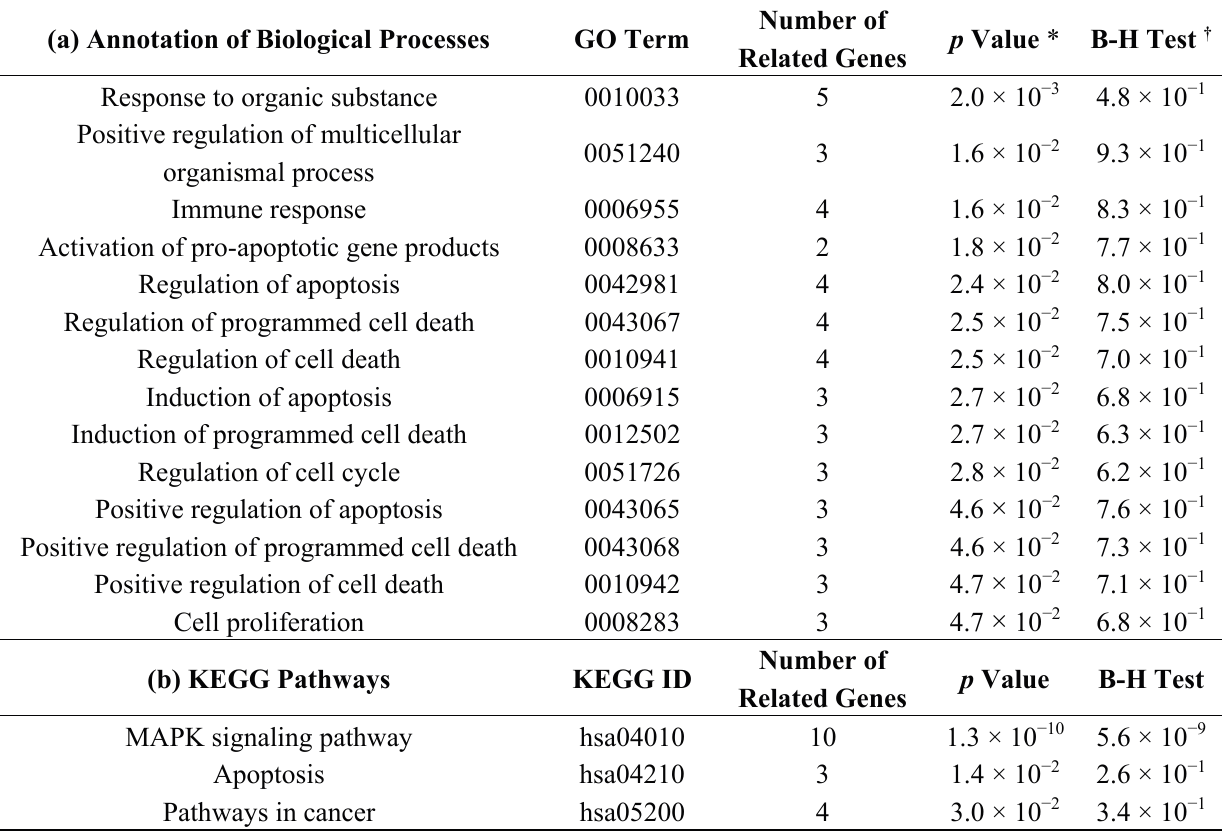
Table 6. Enrichment analysis for biological processes and pathways of unique target genes of